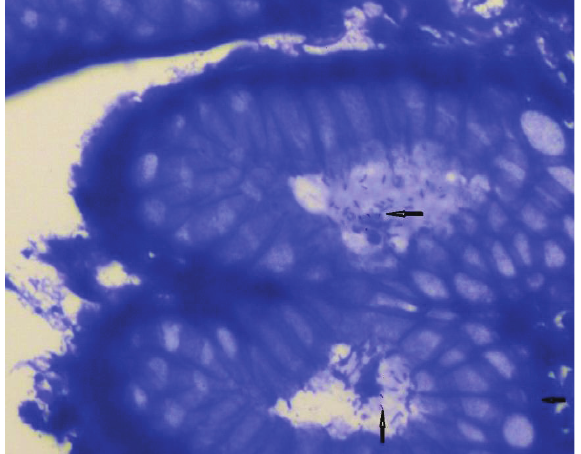
Fig-6: H.pylori on Giemsa staining 40X